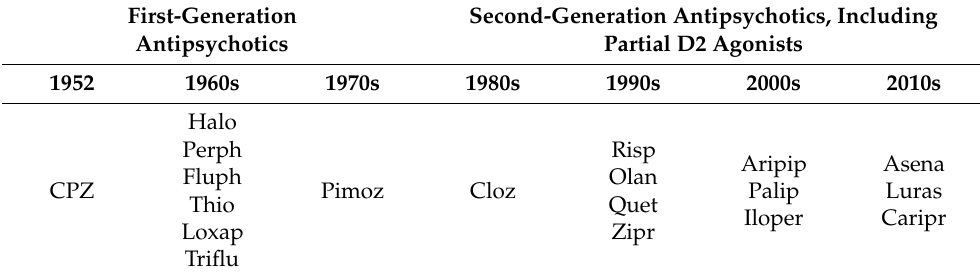
Table 2. Development of first- and second-generation antipsychotic medications.